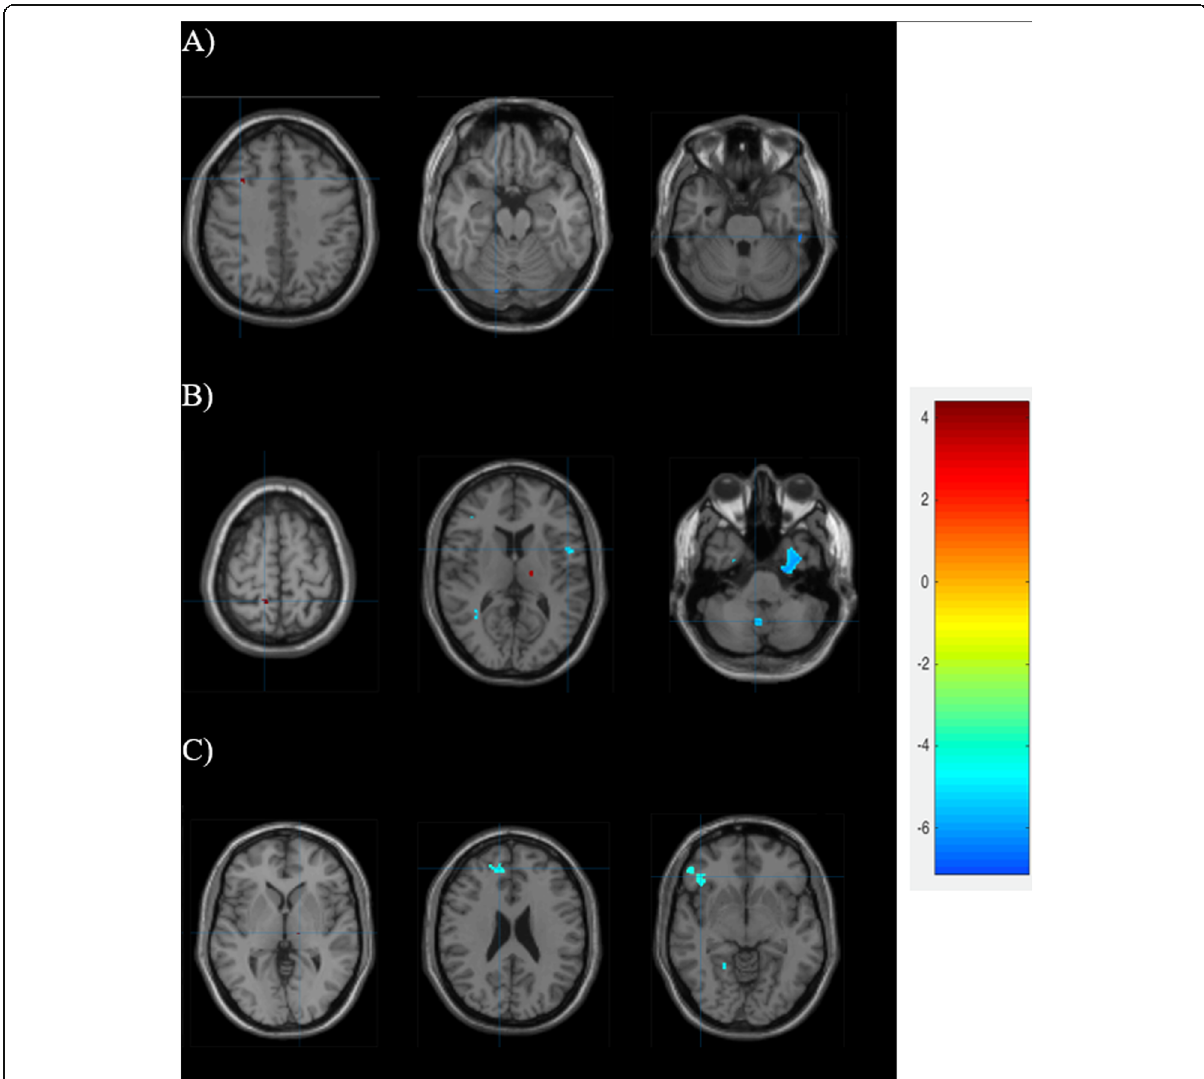
Fig. 1 Gray matter volume (GMV) changes. A) GMV of migraine with aura compared with migraine without aura. B) GMV of migraine with aura compared with health control. C) GMV of migraine without aura compared with health control. Statistical parametric maps show gray matter volume alterations with a threshold of P < 0.001 uncorrected superimposed on a standard T1 image. The color bar reflects t values (red/yellow = increased volume, blue = decreased volume). MwA = Migraine with Aura; MwoA = Migraine without Aura; HS = Heath